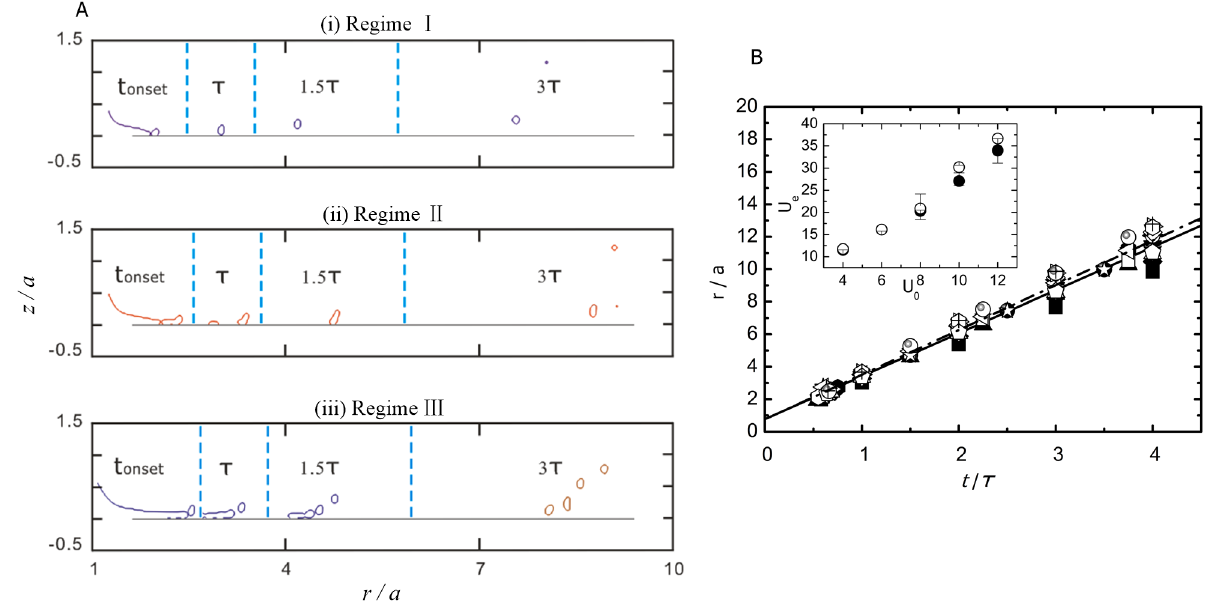
Fig 5. Temporal and spatial evolution of drop splashing in the early stages of impact. A. Three regimesare found to be responsible for the different splashingfeatures shown at the successivetimes t = t onset , τ , 1.5 τ and 3 τ . B. Normalized radial distanceof the outermost ejected droplet as a function of normalizedtime at different Re (solid symbols, Re = 602 to 3840) and We (open symbols, We = 1354to 30082). Different symbol shapes denote different values for Re or We . The inset plots the dimensional radial speedof the outermost ejected droplets U e vs the drop impact speed U 0 . The unit for both the speeds is